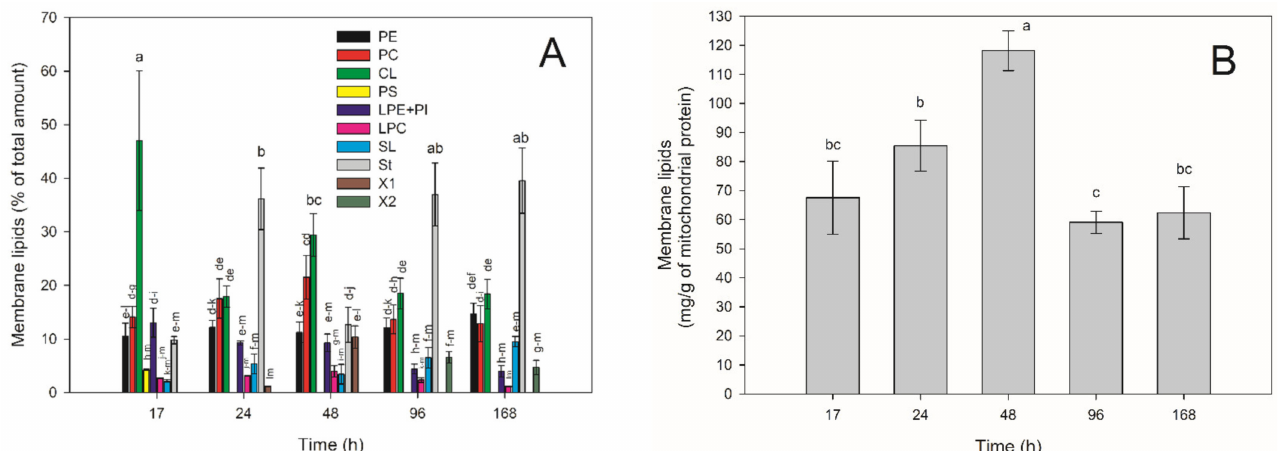
Figure 4. Membrane lipid composition of the mitochondria from E. magnusii cells raised in the different growth phases upon ageing during the seven-day cultivation. ( A )—the share of each membrane lipid fraction; PE—phosphatidylethanolamines; PC—phosphatidylcholines; CL—cardiolipins; PS—phosphatidylserine; LPE + PI—lysophosphatidylethanolamine + phos- phatidylinositols; LPC—lysophosphatidylcholines; SL—sphingolipids; St—sterols; X1, X2—unknown; ( B )—the total mem- brane lipid content. a–m Means with the same letter did not differ